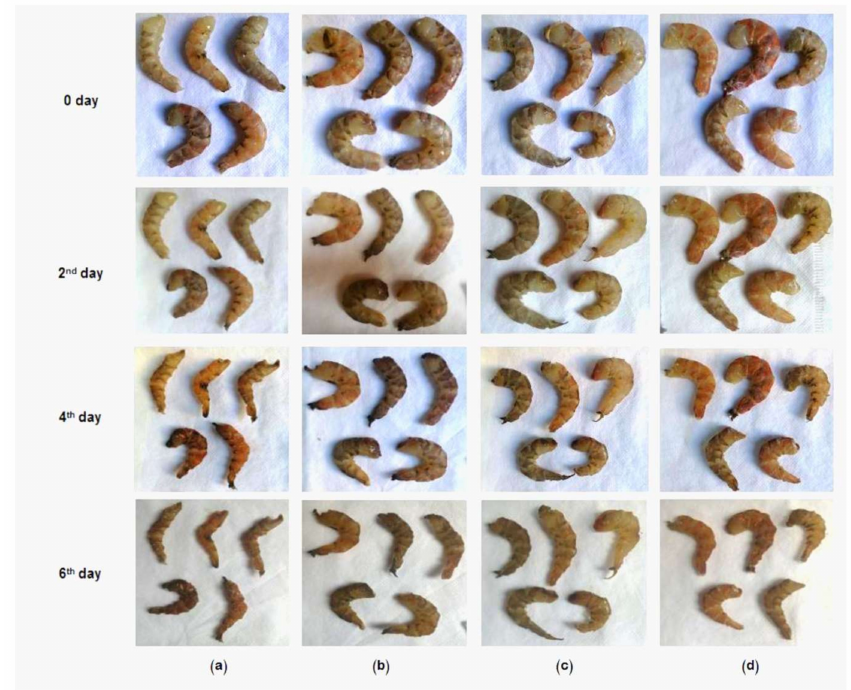
Figure 10. Appearance and texture changes of shrimps stored at 4 ◦ C for 0, 2, 4, and 6 days when treated with 1% UFD-ZnONPs ( b ); 3% UFD-ZnONPs ( c ); and 5% UFD-ZnONPs ( d ) compared to control ( a